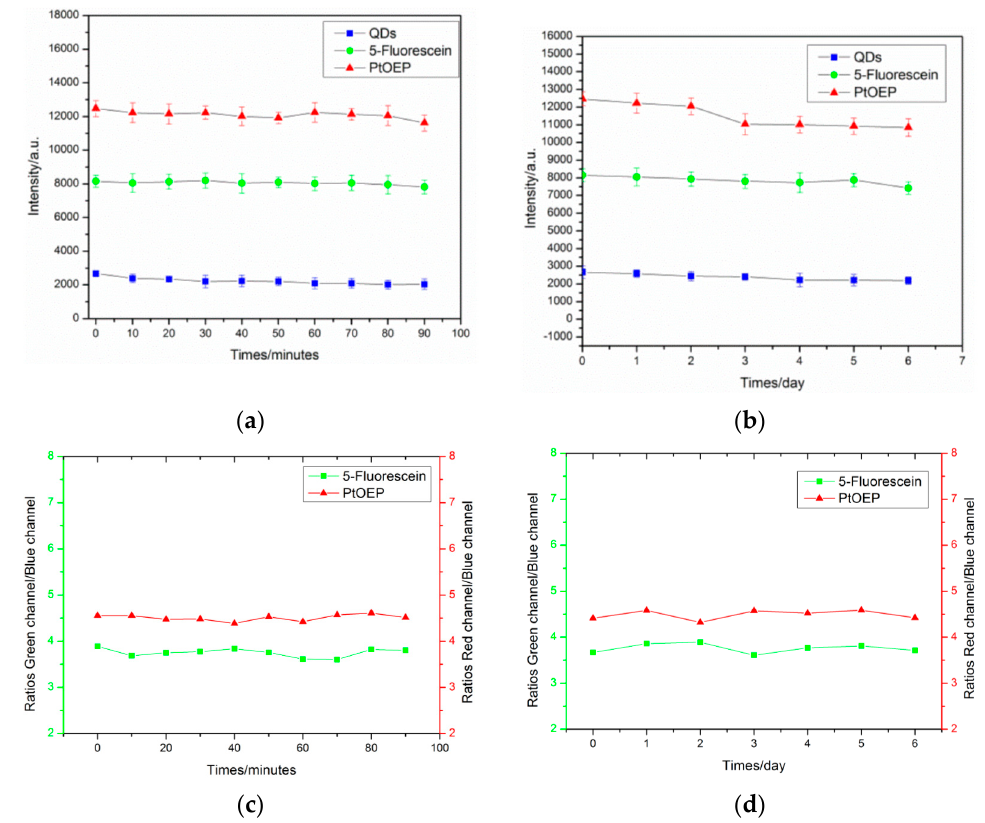
Figure 6. Photostability and long term stability of the pH/Oxygen planar optode. ( a , b ) The relative luminescence intensities of the QDs, 5-Fluorescein, and PtOEP (Platinum(II) octaethylporphyrin). ( c , d ) The ration of the pH/Oxygen planar optode: ratios of Green channel/Blue channel, and ratios of Red channel/Blue channel.